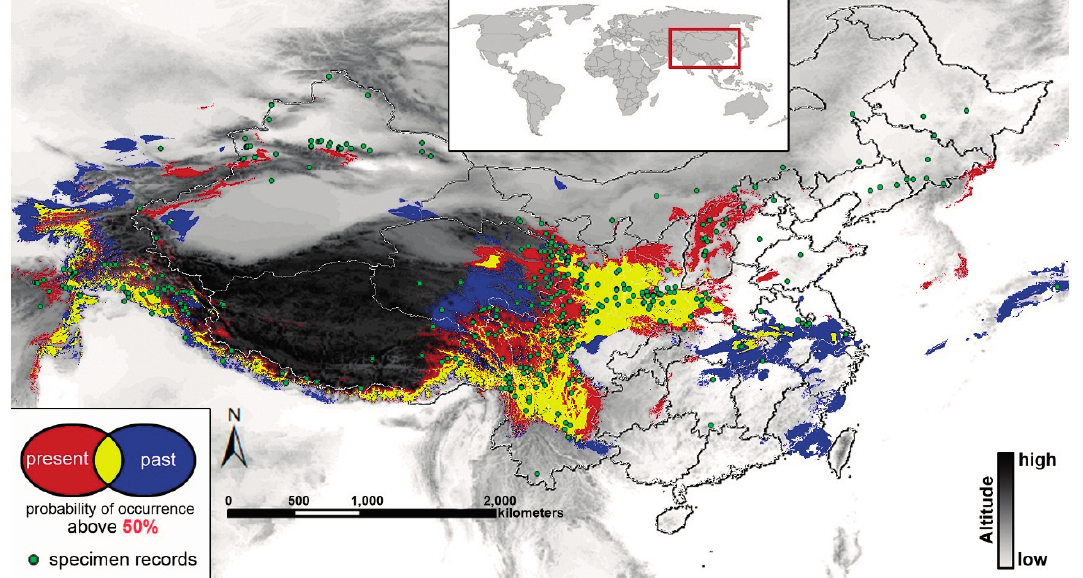
Figure 3. The present ( red ) and past distribution ( blue ) of T. arvense predicted through ecological niche modeling by the software MaxEnt3.3.3k. Only area with a predicted suitability above 50% is shown. Yellow represents the shared area of suitable environmental conditions of both the present and the past. Green dots represent the sampling records used for